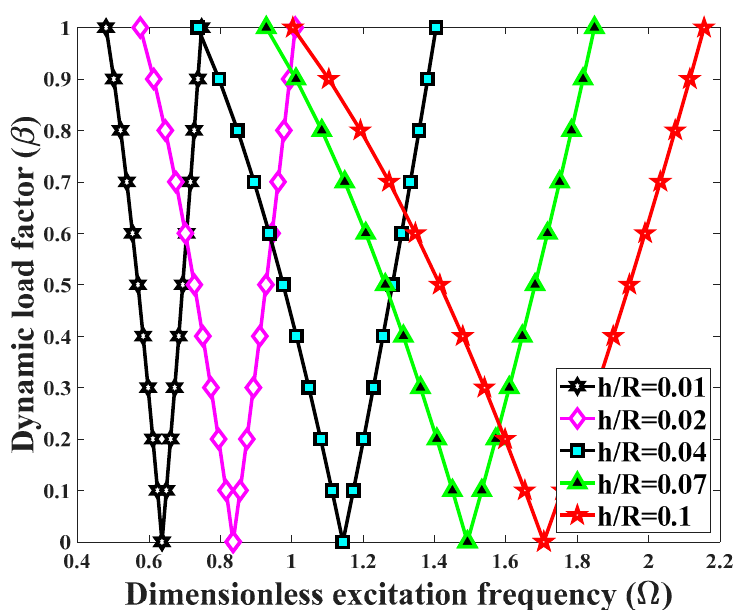
Figure 3. Effect of the thickness-to-radius ratio on the dynamic instability region ( DIR) for a BD- Figure 3. E ff ect of the thickness-to-radius ratio on the dynamic instability region (DIR) for a BD-FG cylindrical shell with R = 0.5 m, L / R = 1, n x = n z = 1, α = 0.3. FG cylindrical shell with